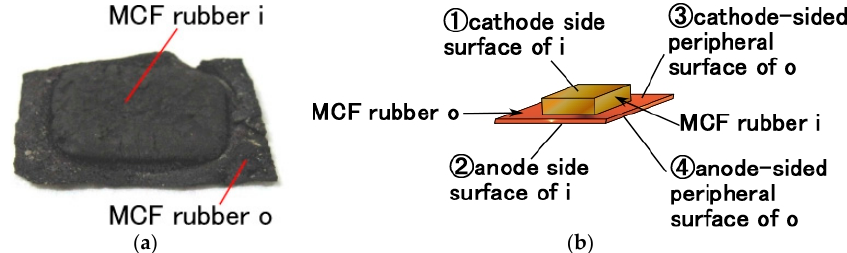
Figure 3. MCF rubber vulcanized by the application of electric and magnetic fields: ( a ) photograph of MCF rubber; ( b ) position of MCF rubber on the measurement of induced and electric resistance by connecting points. Table 2. The electric resistance and induced voltage by connecting different points of MCF rubber: Ω designates electric resistance and mV the induced voltage.